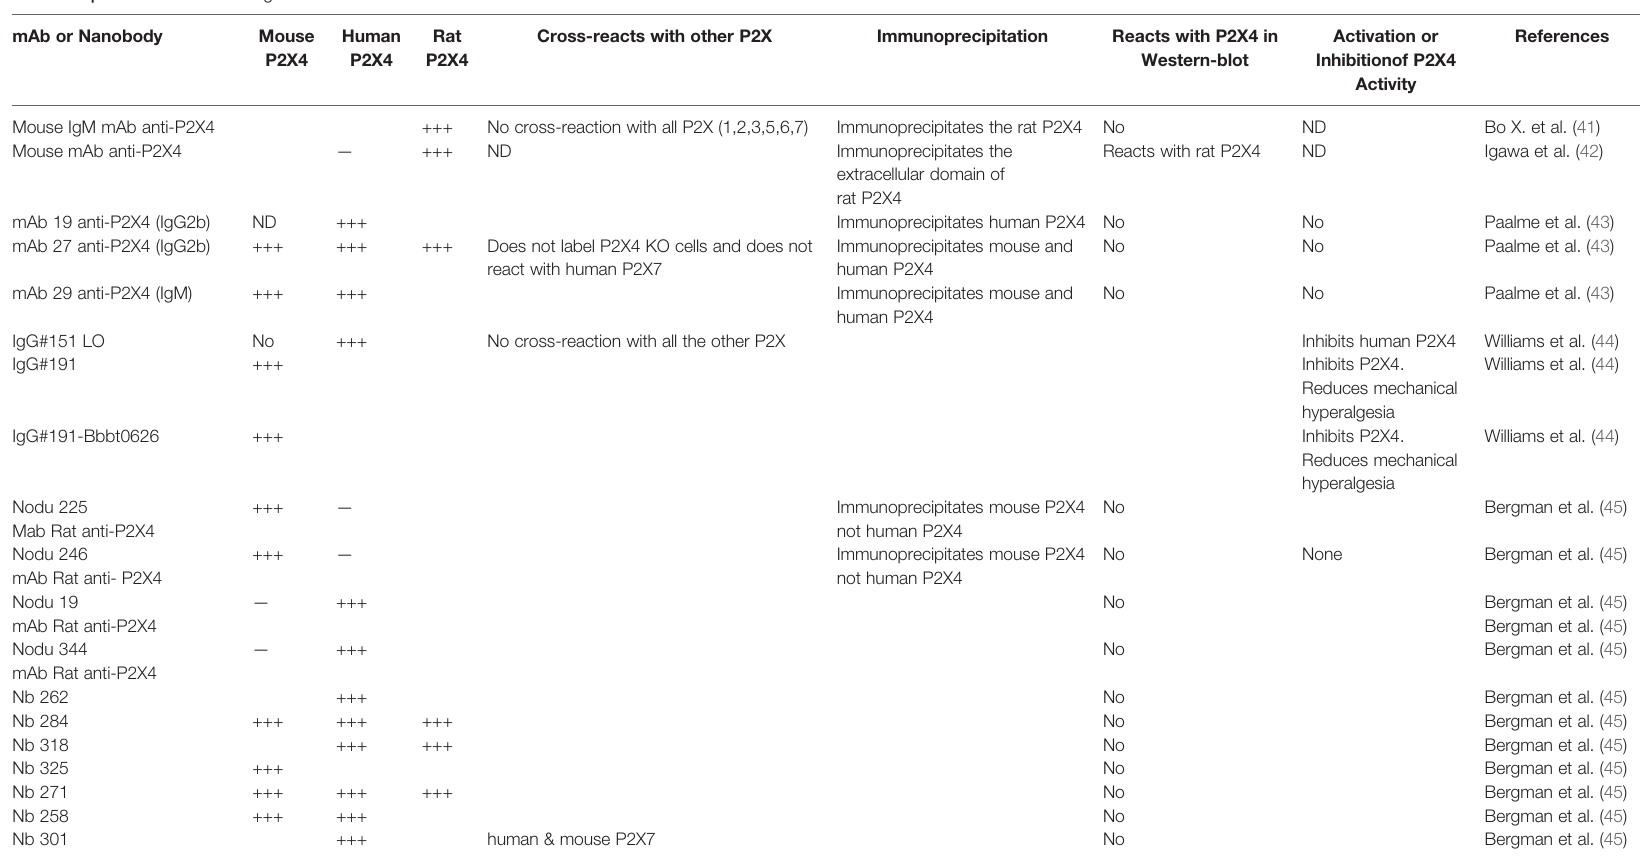
TABLE 1 | Available antibodies against